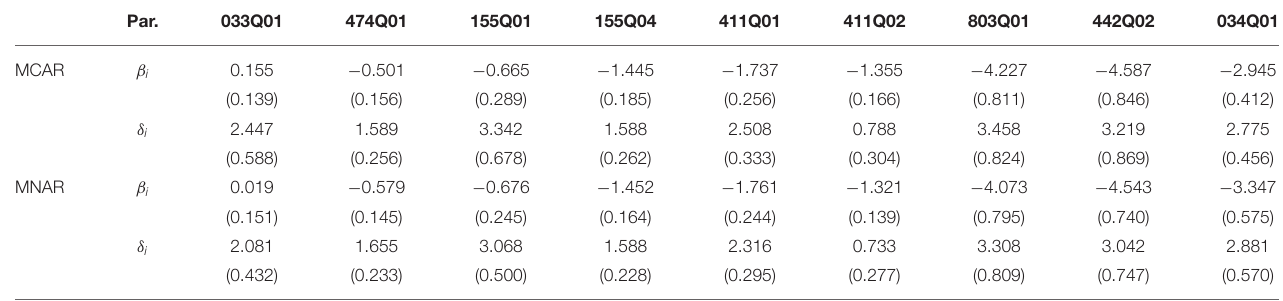
TABLE 7 | Estimates and standard errors of the parameters for the real data.